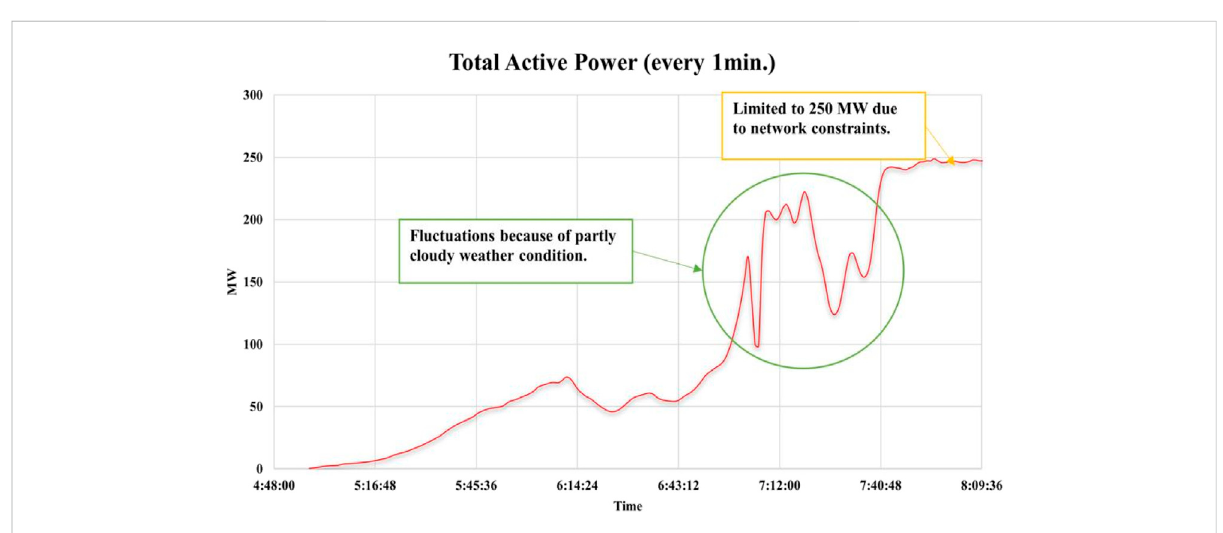
FIGURE 14 Hourly active power generated from PV farm.